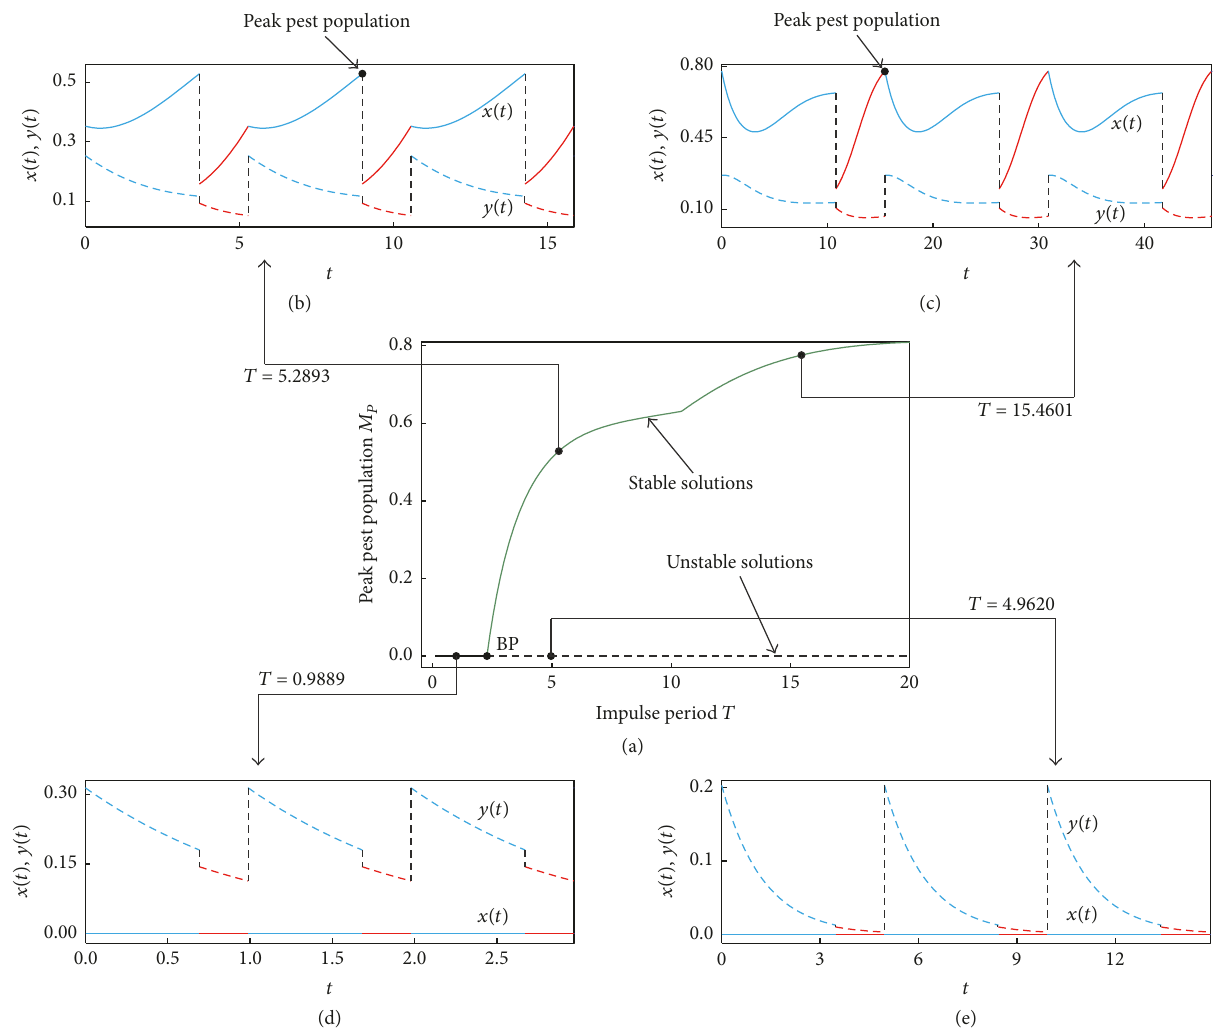
Figure 2: (a) One-parameter continuation of the periodic response of system (14), with respect to the impulse period 𝑇 . The solid and dashed lines stand for stable and unstable solutions, respectively. In what follows, this convention will be used to denote stability in a bifurcation diagram. (b)–(e) present time histories for different values of impulse period. Here, the pest and natural enemy populations are displayed with solid and dashed lines, respectively. Throughout the paper, pest and natural enemies will be distinguished in a time history in this